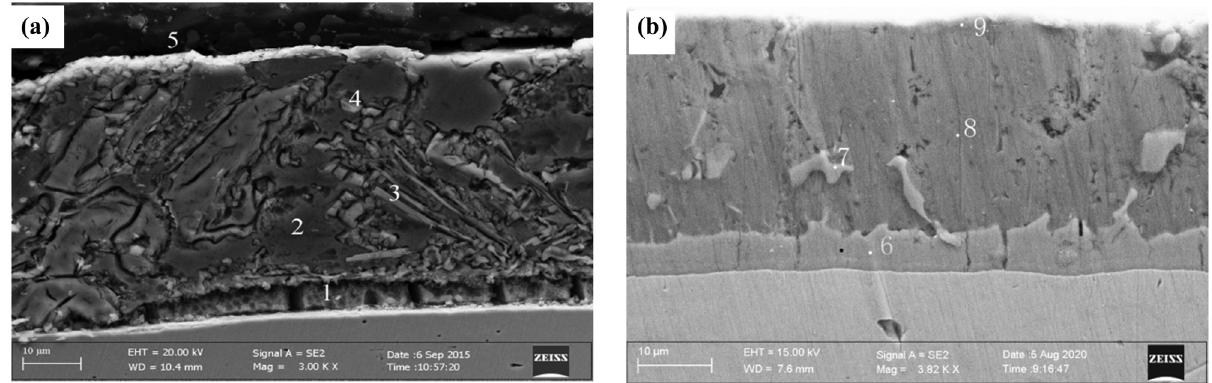
Figure 10: SEM microstructure and spot EDS position of coatings: ( a ) Al – Si – Cu coating and ( b ) Al – Si